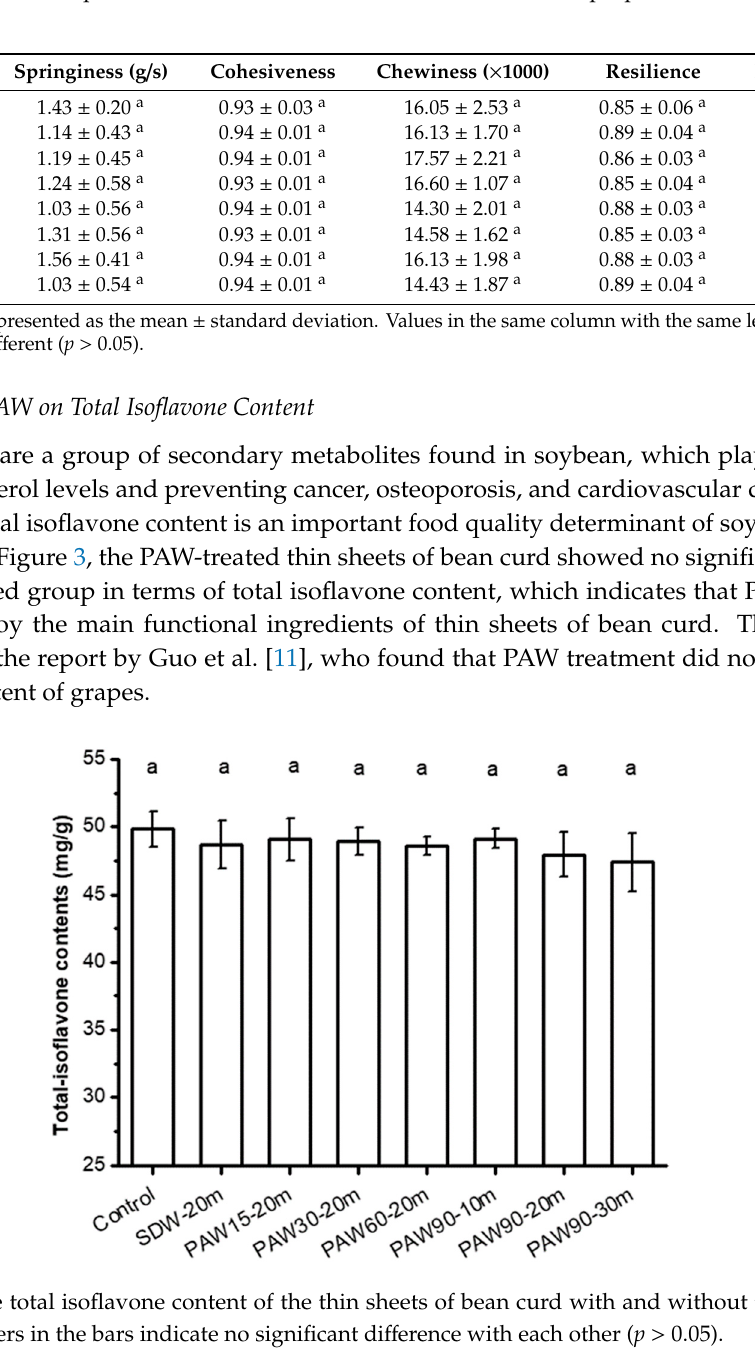
Table 3. Influence of plasma-activated water treatment on the sensory characteristics of thin sheets of bean curd.